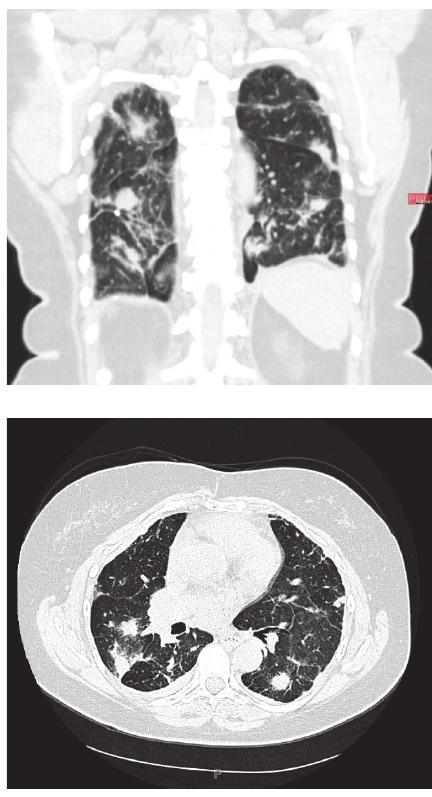
Figure 1: Computed tomography (CT) scan of the chest reveals diffuse parenchymal nodularity, with no honeycombing, hilar, or mediastinal adenopathy, consistent with stage III sarcoidosis.